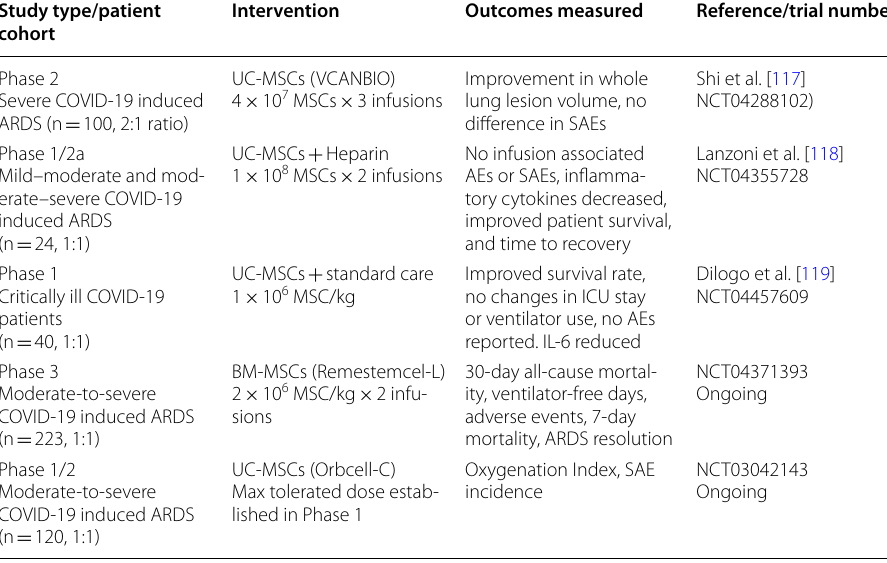
Table 3 Randomized controlled clinical trials of MSC therapy for COVID-19 Study type/patient